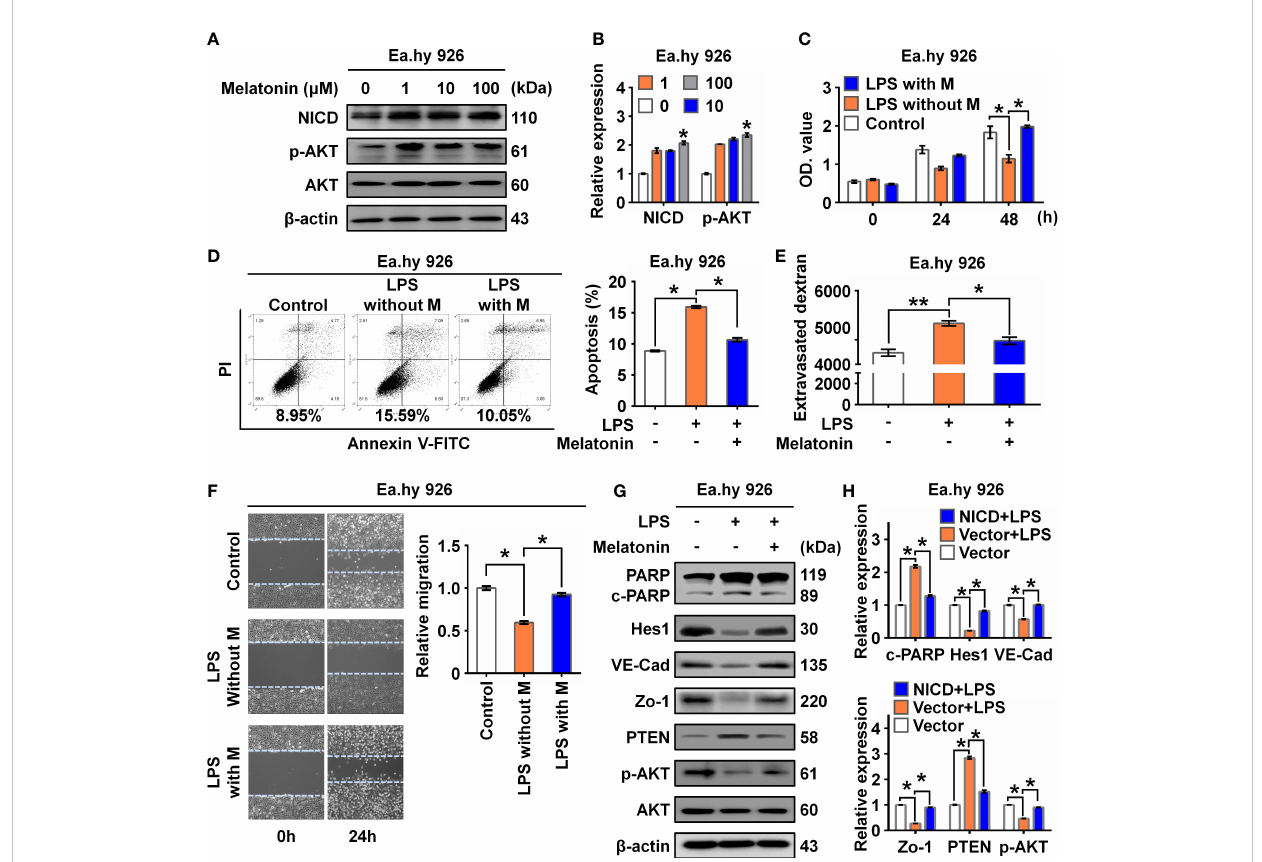
FIGURE 4 Melatonin alleviated LPS-induced endothelial dysfunction. (A, B) The level of NICD and p-AKT in Ea.hy 926 cells treated with indicated concentrations of melatonin were tested with Western blot. Representative images (A) and three experiments replicates (B) were displayed. (C) CCK8 assay was used to evaluate the proliferation of Ea.hy 926 cells treated with the control, LPS without melatonin or LPS with melatonin for indicated time. (D) The apoptosis of Ea.hy 926 cells treated with indicated conditions tested with Annexin V-FITC/PI staining by fl ow cytometry. Representative images (D) -left) and statistical analysis of apoptosis (D) -right) for Ea.hy 926 cells treated with the control, LPS without melatonin or LPS with melatonin were shown. (E) The endothelial permeability was determined by the transwell assay after being treated with the control, LPS without melatonin or LPS with melatonin. (F) The migration of Ea.hy 926 cells was tested by wounding healing assay after being treated with the control, LPS without melatonin or LPS with melatonin. Representative images (F) -left) and statistical analysis of migration (F) -right) of Ea.hy 926 regulated by indicated treatment were shown. (G, H) The protein levels of cleaved PARP, Hes1, VE-Cad, Zo-1, PTEN, and p-AKT were tested in LPS-treated Ea.hy 926 cells with or without melatonin. Representative images (G) and three experiments replicates (H) were displayed. The data were obtained from three independent experiments. Data are shown as the mean ± SEM. * p < 0.05. ** p <